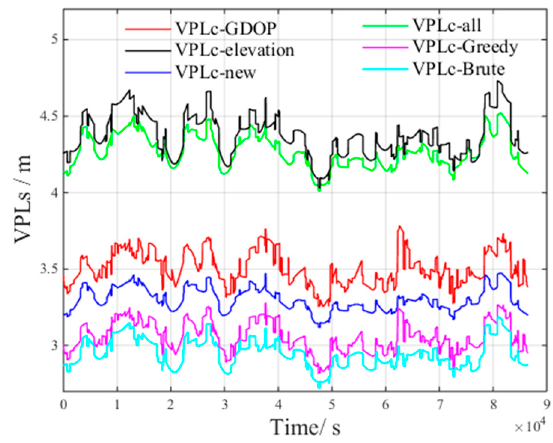
VPL of the new method under non-nominal troposphere. Figure 22. VPL C of the new method under non-nominal Figure 22. C